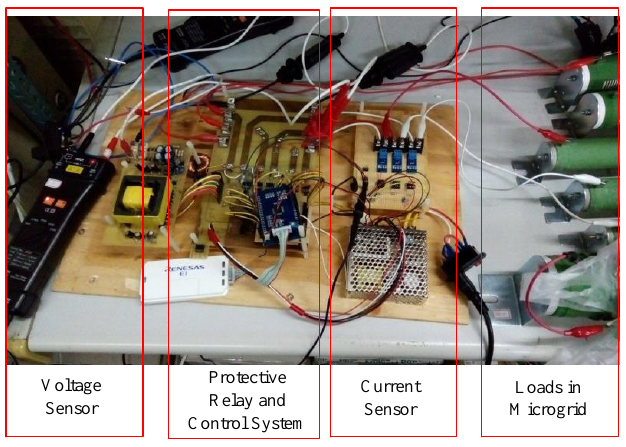
Figure 7. Experimental setup.